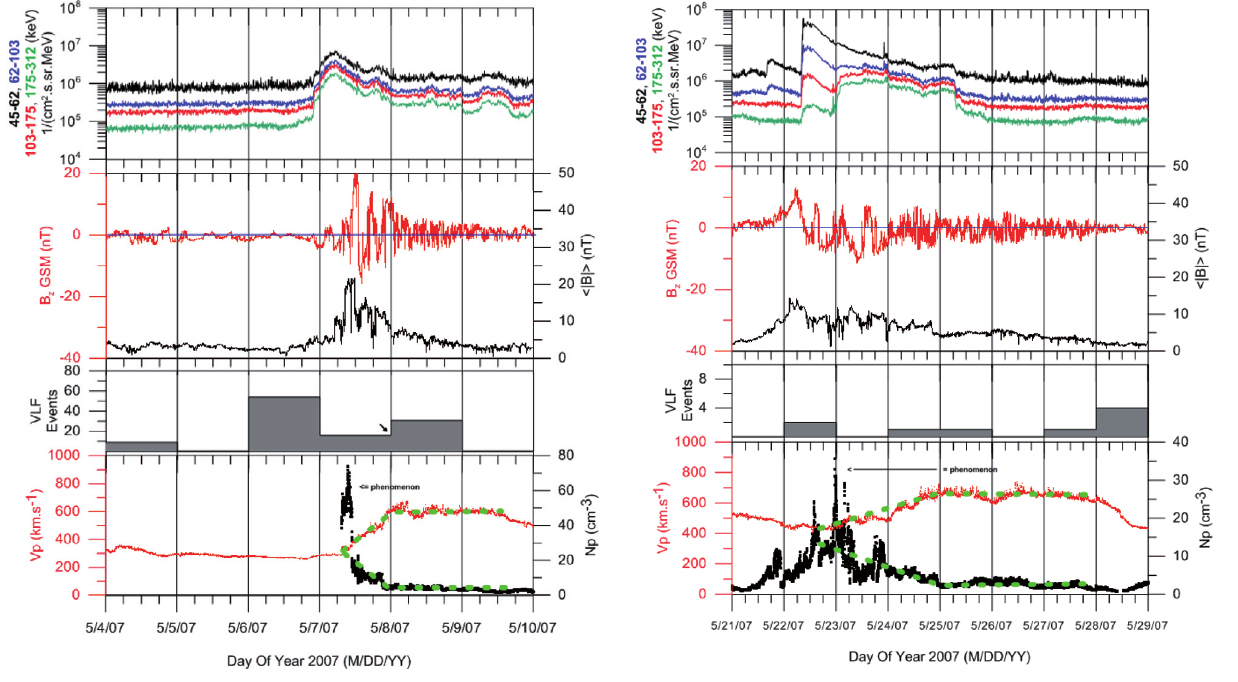
Figure 9. As for Figure 5, for Case E: May 4-8. Figure 10. As for Figure 5, for Case F: May